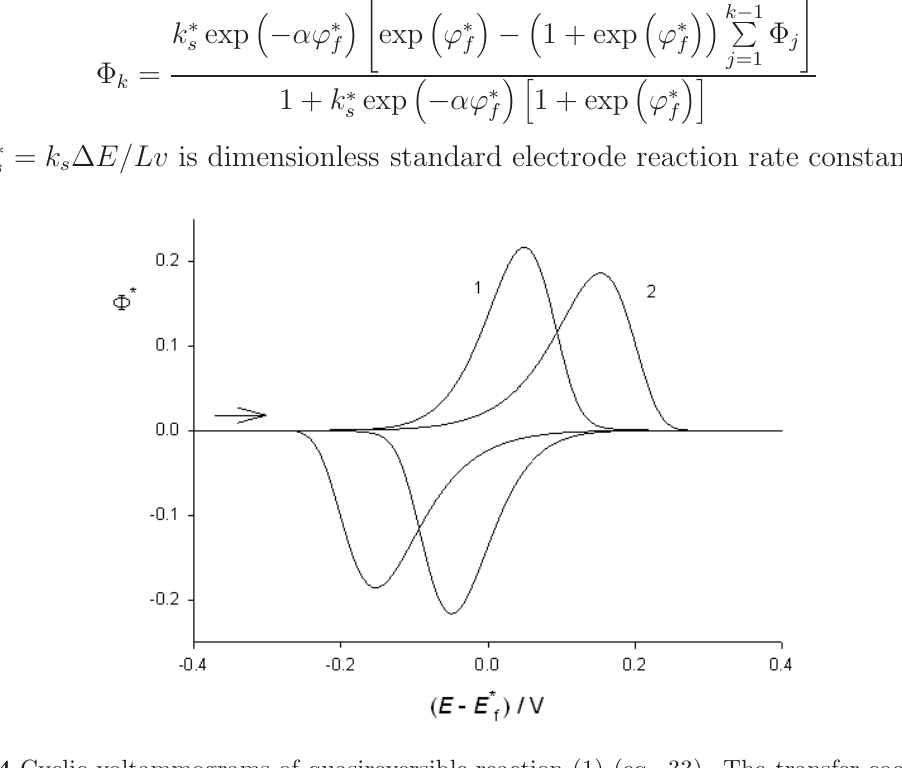
= 10 − 3 (1) and 10 − 4 s